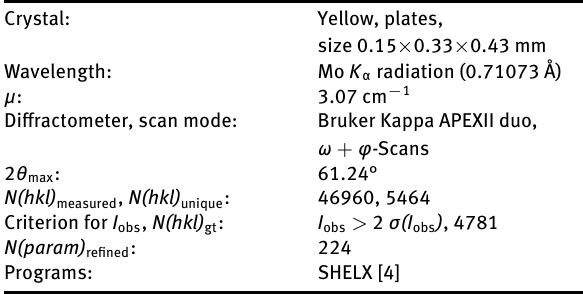
Table 1: Data collection and handling.